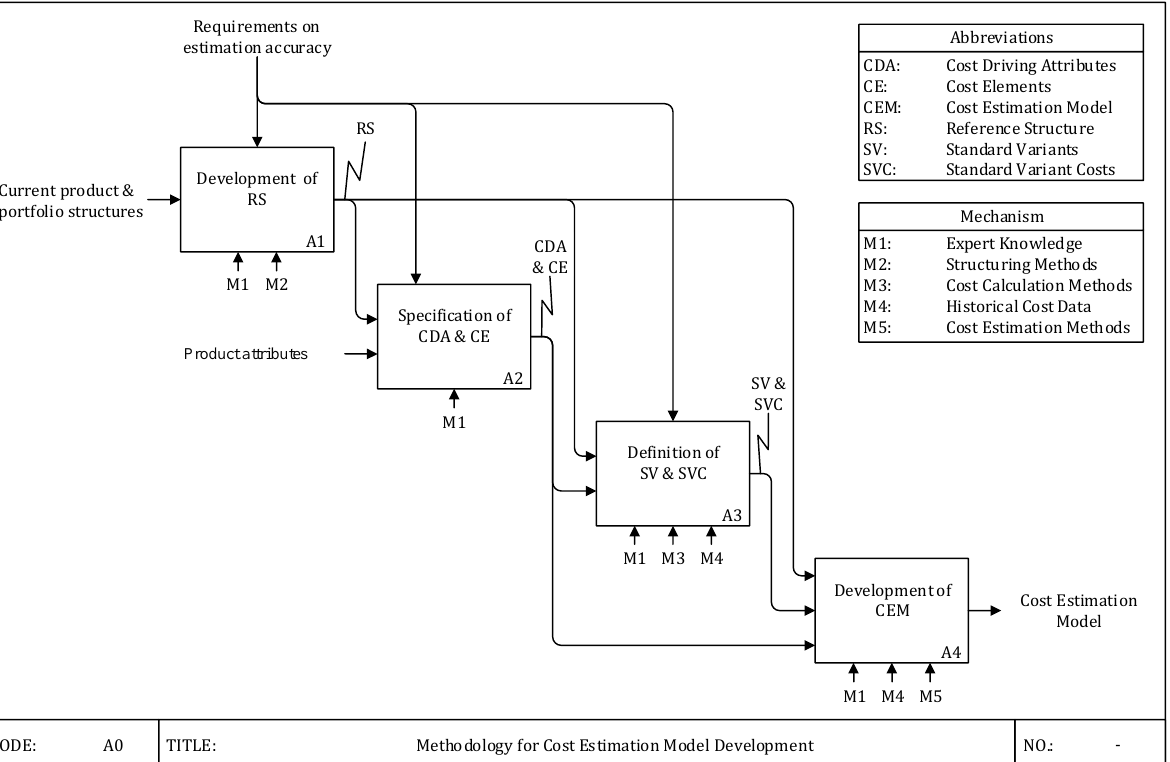
Fig. 5: Generic development methodology for cost estimation models Figure 5: Generic development methodology for cost estimation